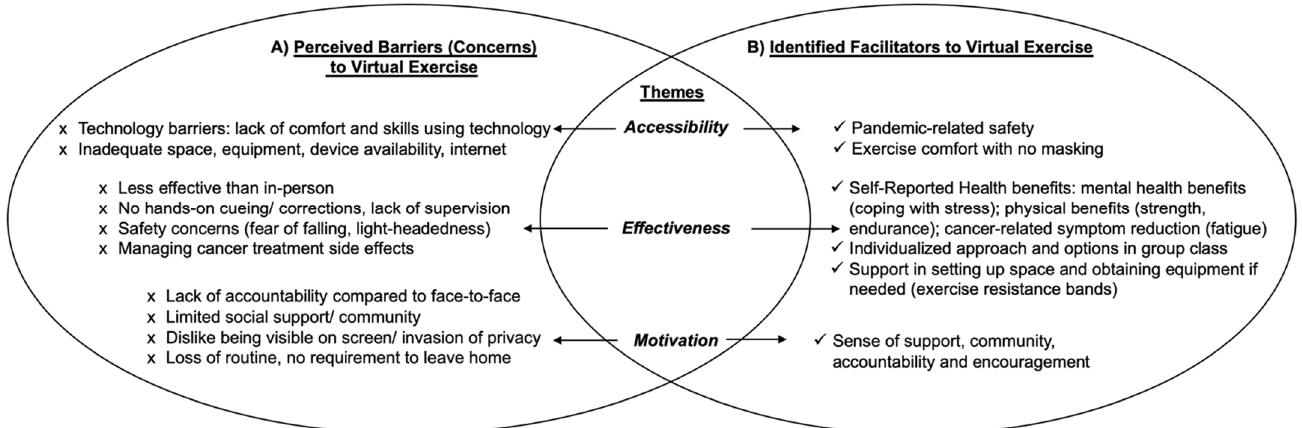
Figure 3. Perceived Barriers and Identified Facilitators towards Virtual Exercise Programming.